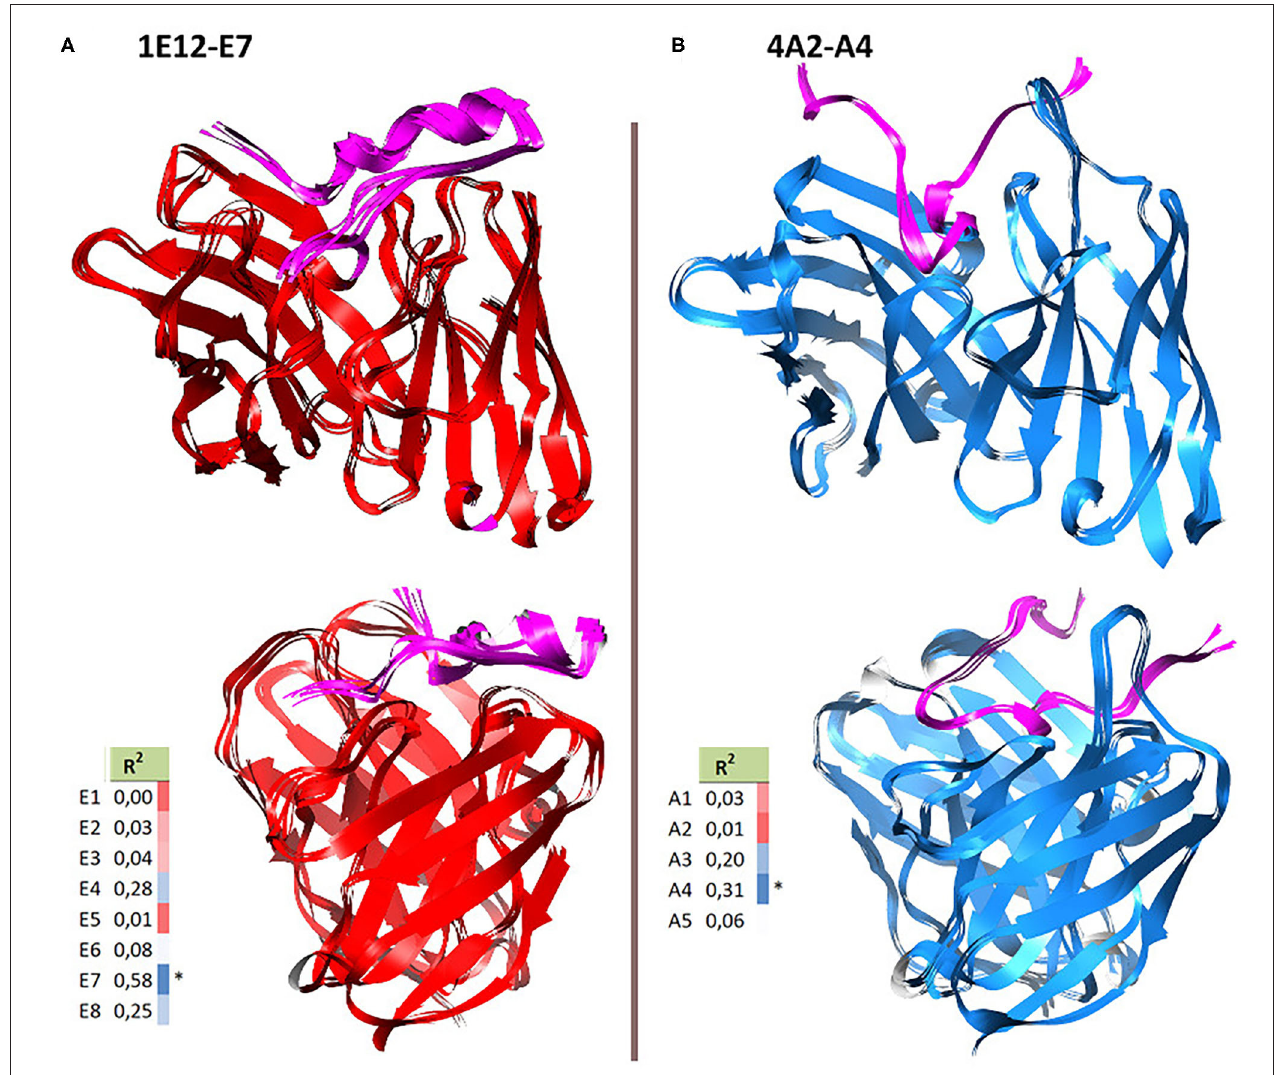
FIGURE 5 | Top docking solutions emerging from the integral modeling protocol. Two perspectives of the interaction topologies between the FMDV AgSA peptide (pink) and mAbs 1E12 (red) and 4A2 (blue) are shown in vertical panels (A,B) , respectively. Note that the peptide has a flatter interaction with 1E12 mAb, unlike the interaction with 4A2, where the peptide would be more embedded in the